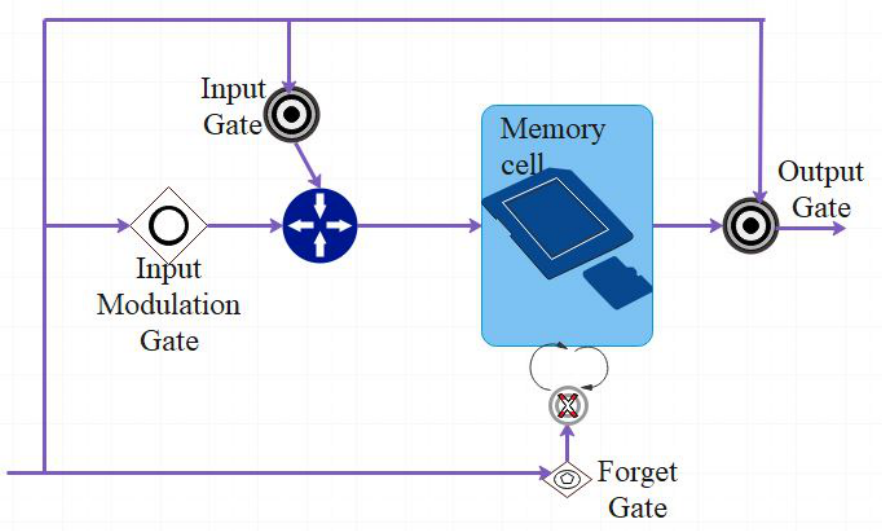
Figure 5. The Structure of Long Short Term Memory Model.